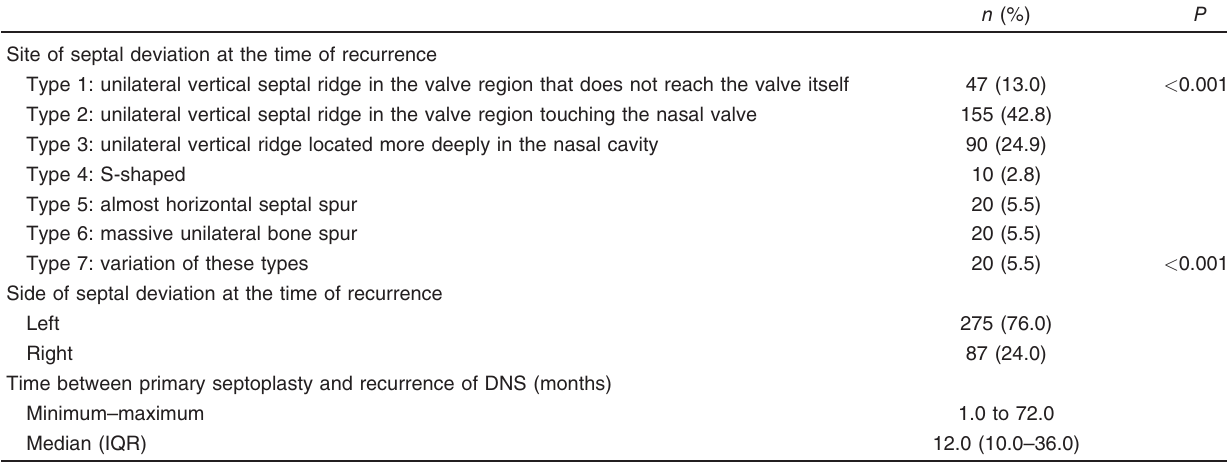
DNS, deviated nasal septum; IQR, interquartile range. * P < 0.05,